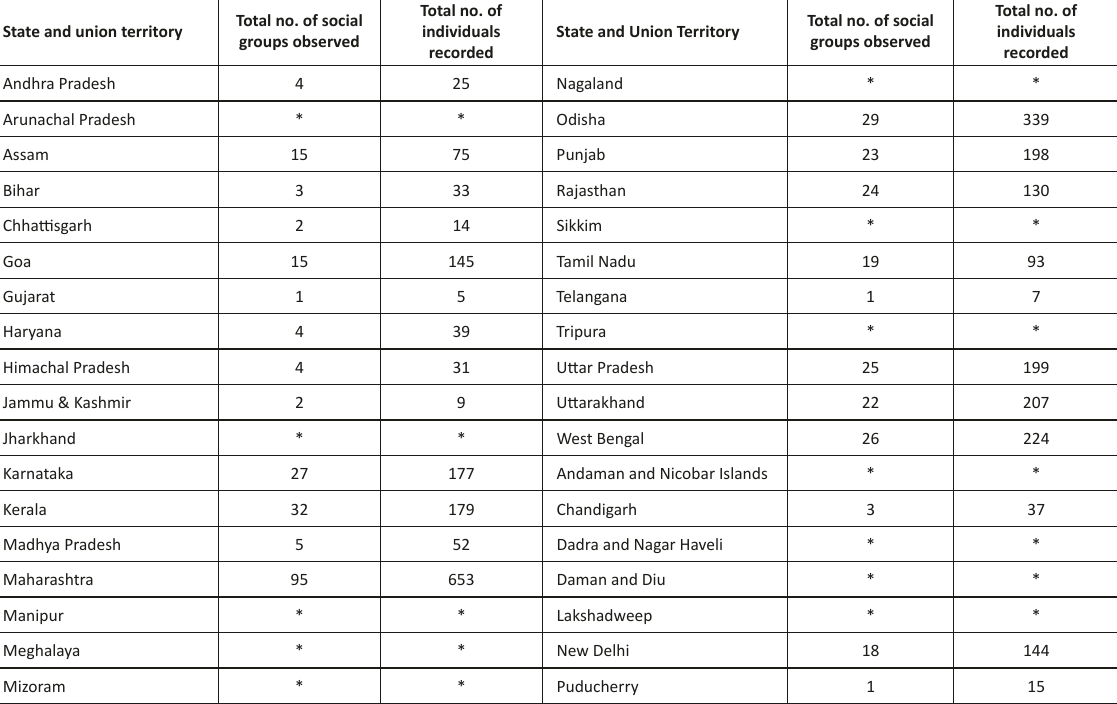
Table 1. Total number of individual Jungle Babblers (n=3,030) and social groups (n=400) observed in the various States and Union Territories (n=24) of India (* = no observations; currently under investigation) State and union